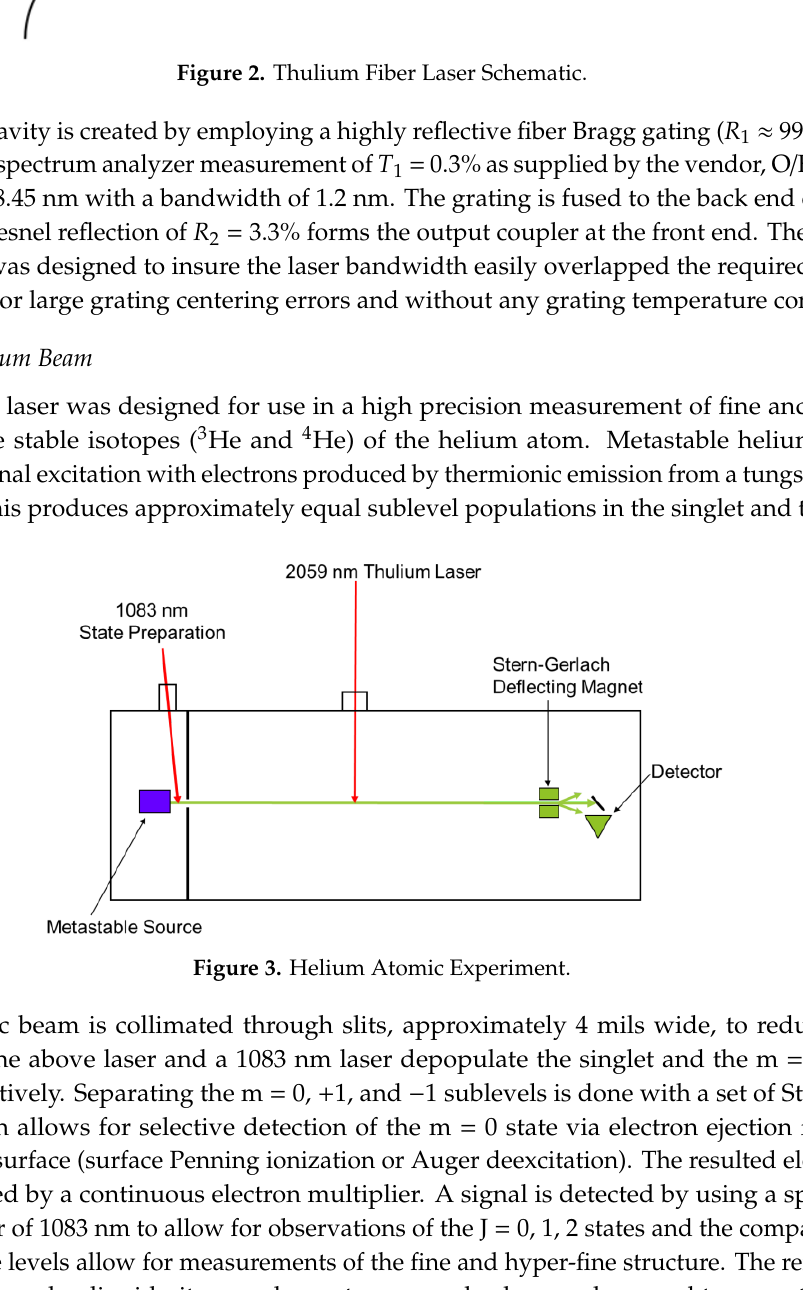
Figure 3. Helium Atomic Experiment.